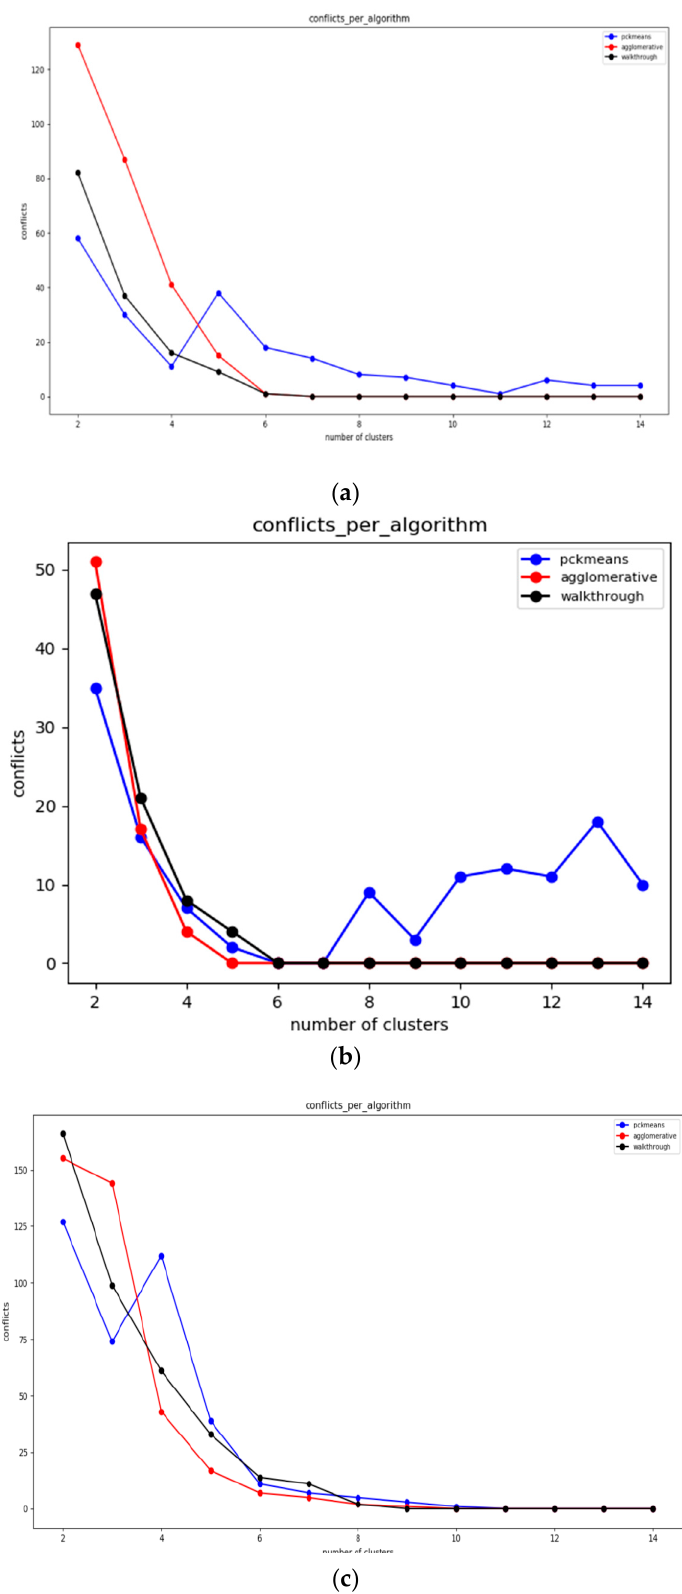
Figure 7. Evaluation results for static clustering over the topology of 37 nodes ( a ) r s = 3, a = 2 and ann = 9.2, ( b ) r s = 1.5, a = 2 and ann = 5.7 ( c ) r s = 4.5, a = 4.7, and ann = 17.8.